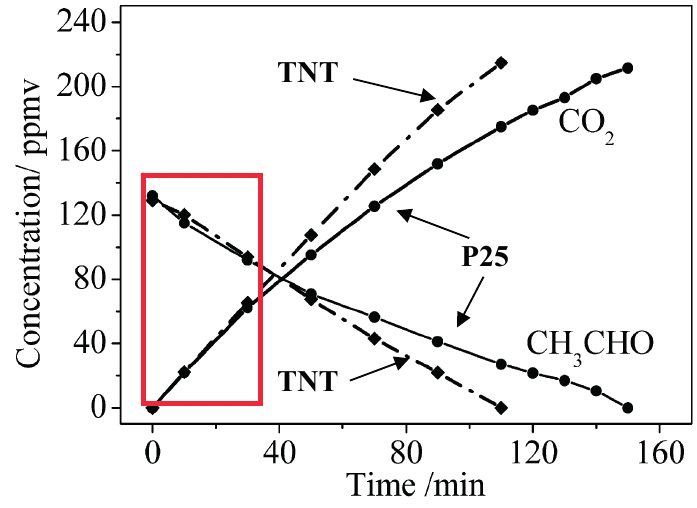
Figure 6. Kinetic variations in the concentrations of CH 3 CHO and CO 2 during CH 3 CHO removal when either TNP or a P25 TiO 2 film was the photocatalyst. Reproduced with permission from reference